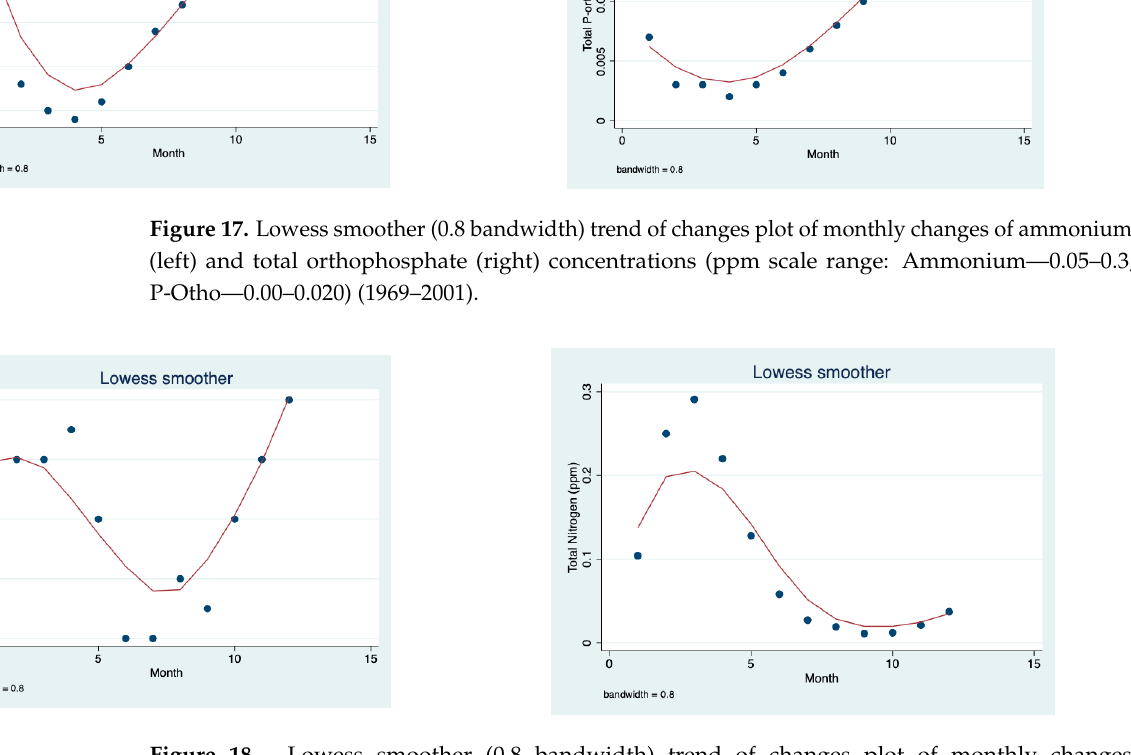
Figure 18. Lowess smoother (0.8 bandwidth) trend of changes plot of monthly changes of total phosphorus (left) and total nitrogen (right) concentrations (ppm scale range: Total Phosphorus—0.018–0.026; Total Nitrogen—0.0–0.3) (1969–2001).